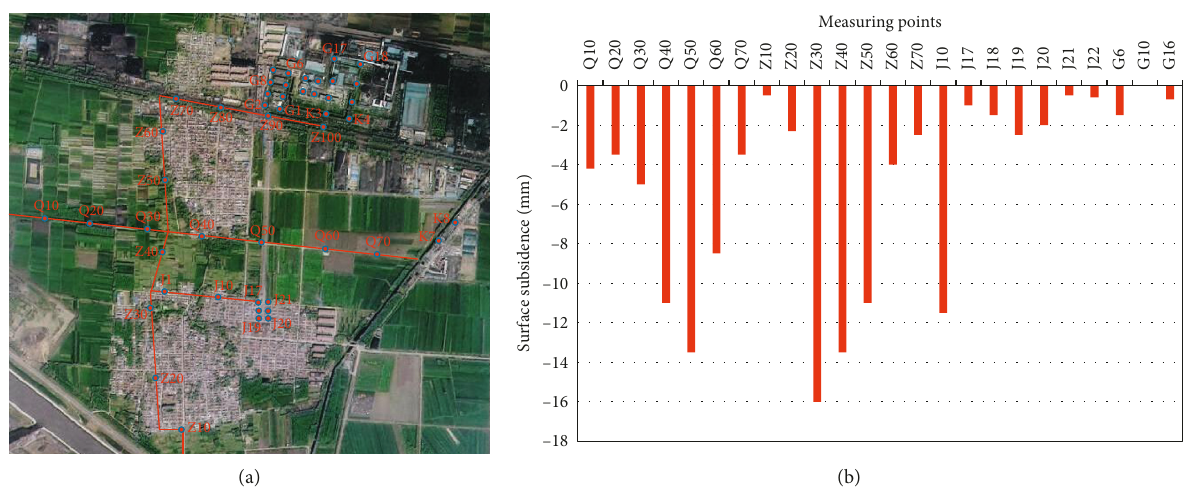
Figure 14: Surface subsidence monitoring results at the working area. (a) Actual measurement plan. (b) Surface subsidence measured from the measuring